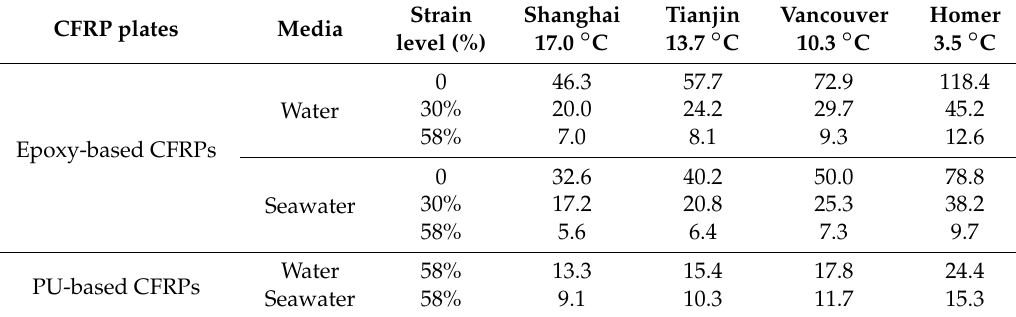
Table 8. Service lives (years), required for the tensile strength retention to reach 50%, of both epoxy- and PU-based CFRPs in various conditions in the four